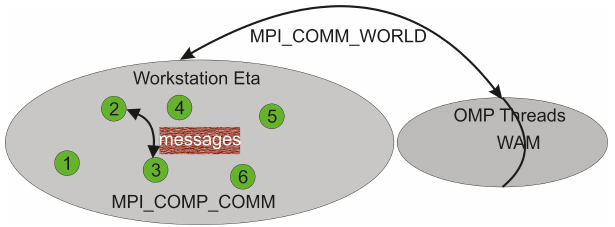
Figure 5. The WEW intra- and inter-communicators. Figure 6. Informational flowchart for the offline coupled (red lines) and the two-way coupled simulations (blue lines).